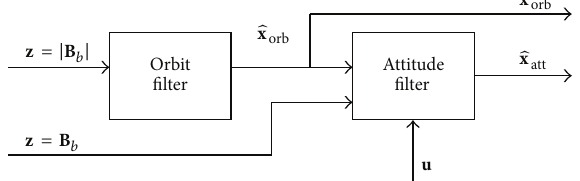
Figure 1: Sequential orbit and attitude determination